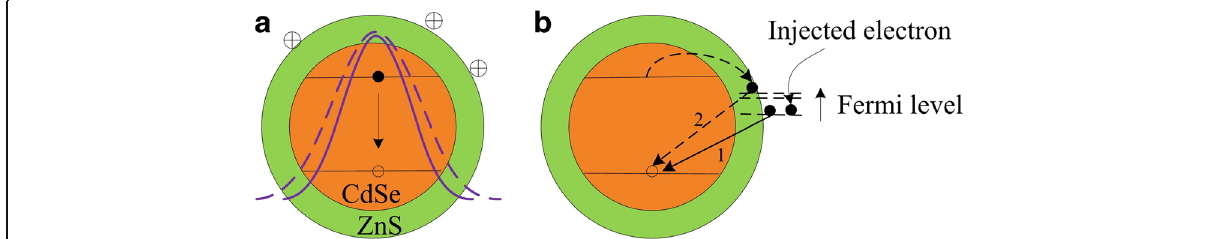
Fig. 5 Schematic diagram showing the effects of cation adsorption and electron injection. a Effect of cation adsorption on the electronic wavefunction of a photoexcited electron (solid violet curve represents QDs without adsorption and dashed violet curve represents QDs with adsorption). b Modulation on surface emission of QDs by injected surface electrons. With increasing negative potential, the lower surface states are progressively occupied by the injected electrons, and the surface emission blueshifts in energy from step 1 to step